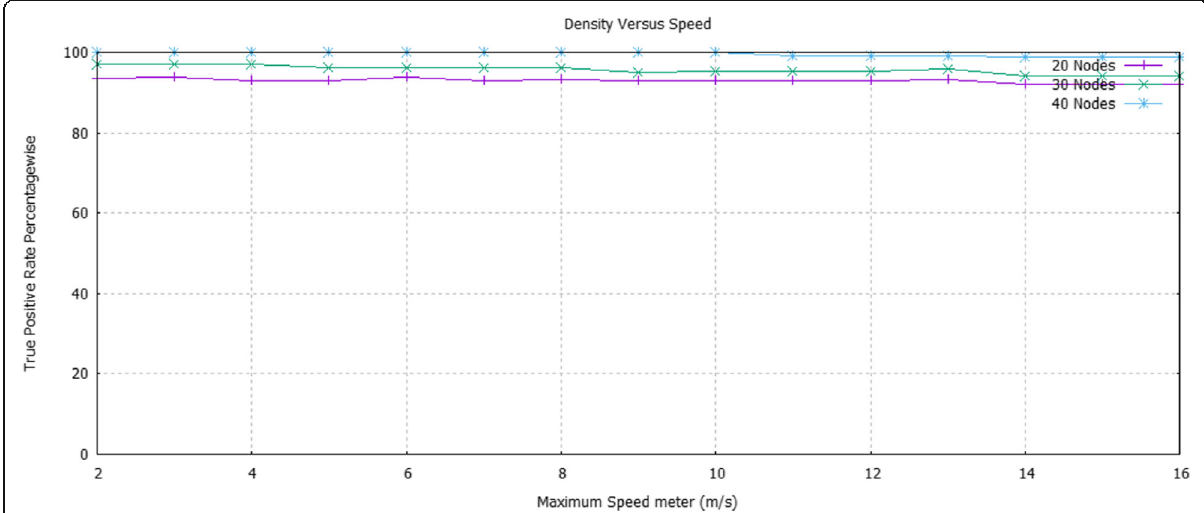
Fig. 10 Density versus speed true positive rate. Shows the simulation results of the density versus speed experiment. The x -axis represents the maximum speed per metre second, while the y -axis represents the TPR. The experiment was conducted in three different instances of 20, 30 and 40 mobile nodes